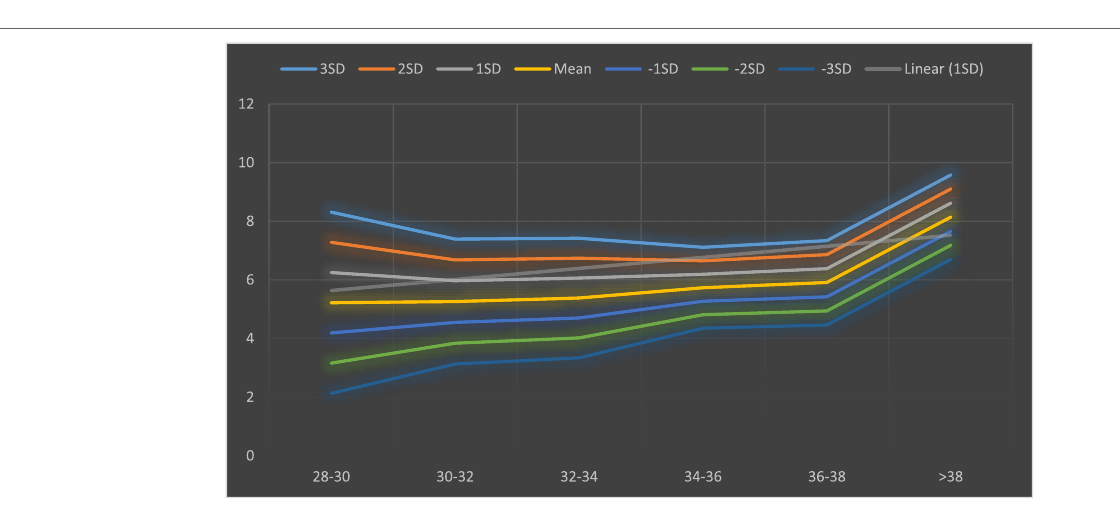
Birth hl head circumference weight